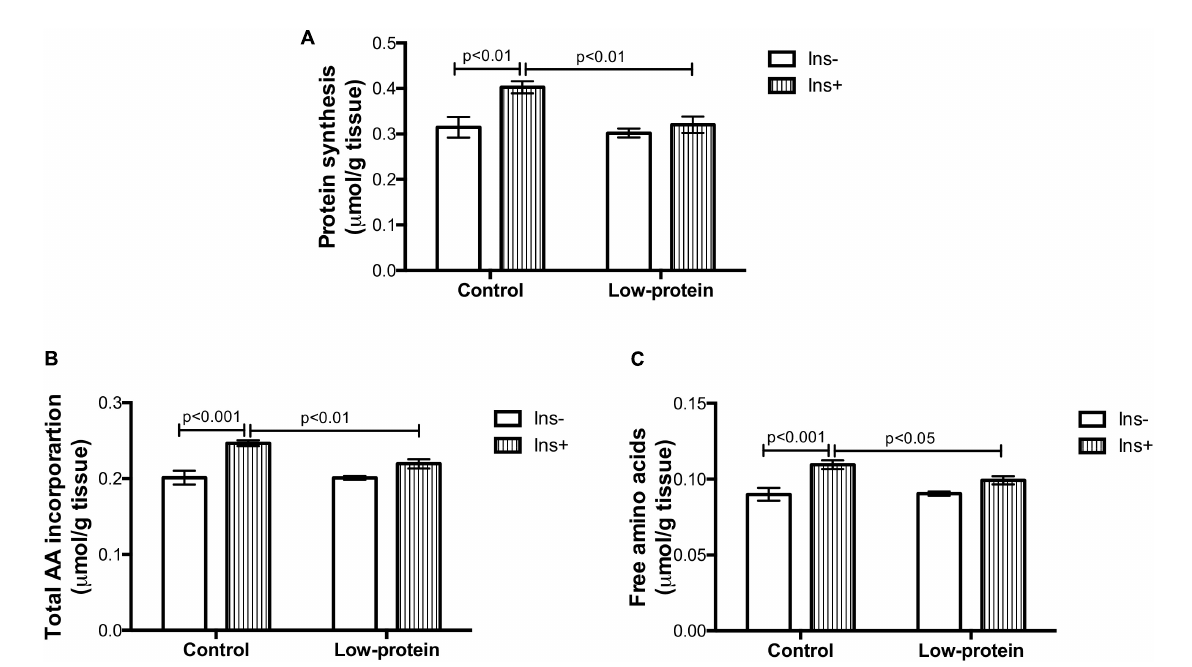
FIGURE3 Long-term effects of low-protein diet during early life on protein metabolism in soleus muscle isolated from rats. (A) Protein synthesis rate, (B) total amino acid incorporation, and (C) free amino acids in isolated soleus muscle with or without insulin in 7-month-old pups from mothers fed a normoproteic (control, n = 6–8) or low-protein (LP, n = 6–8) diet during pregnancy and lactation. Results were analyzed using two-way ANOVA followed by Bonferroni post-test. Values expressed as mean ± SEM.